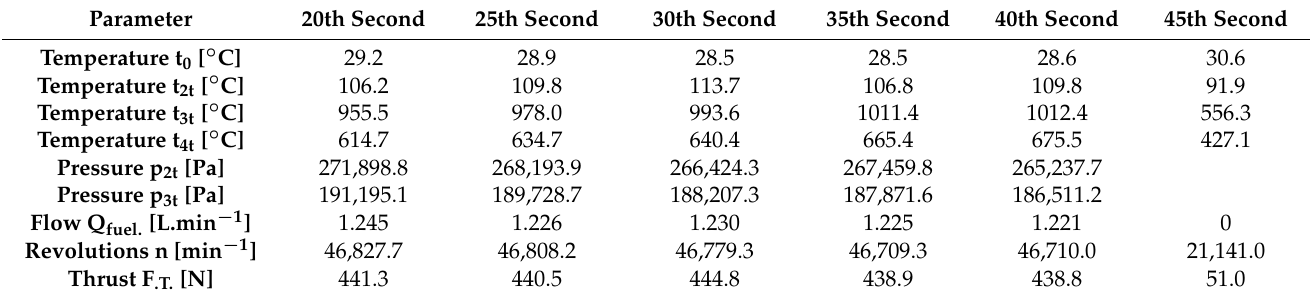
Table 7. Mixture of 90% Jet A-1 aviation kerosene and 10% FAME biofuel, 1st launch (40th